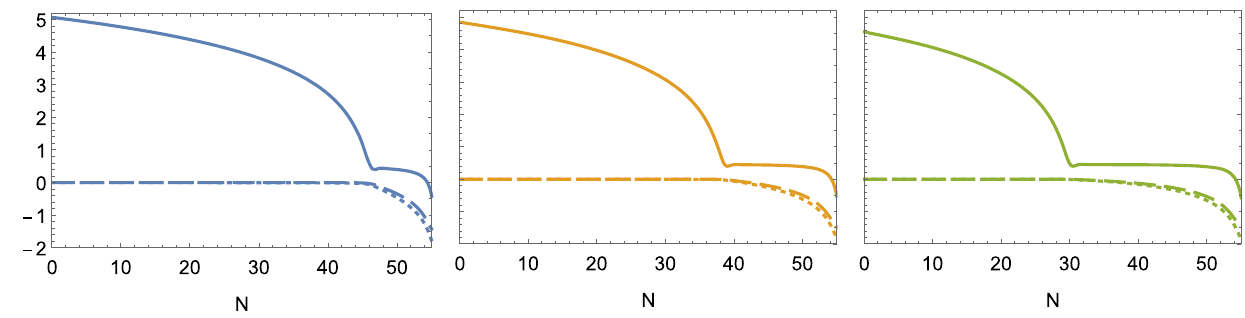
Fig. 8 Evolution of ϕ (solid line), ρ (dotted) and σ (dashed) during the last 55 e-folds for the parameter sets (45) with c = 0 . 1 on the left, c = 0 . 03 in the center, and c = 0 . 01 on the right